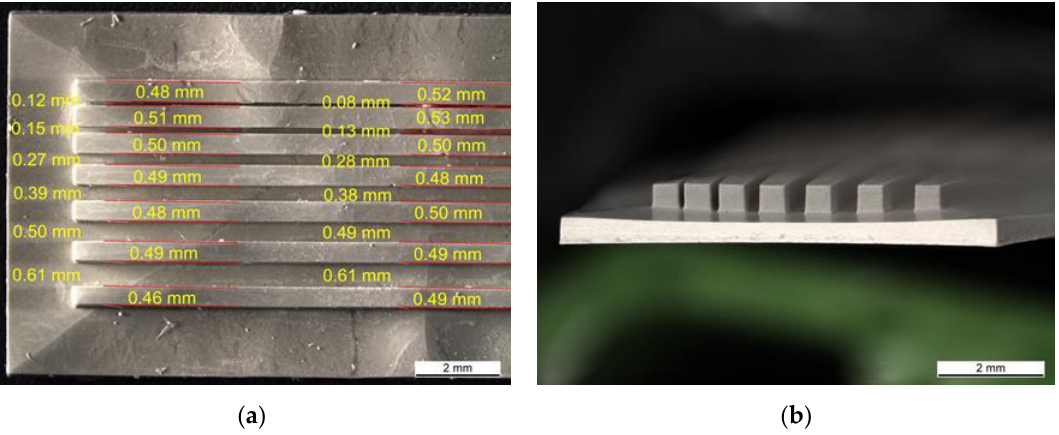
Figure 9. Plate with channels structure fabricated on the LCM device from a suspension containing 0.5 wt % TPO-L and 10 µm printing layer thickness. ( a ) top view, ( b ) side view.